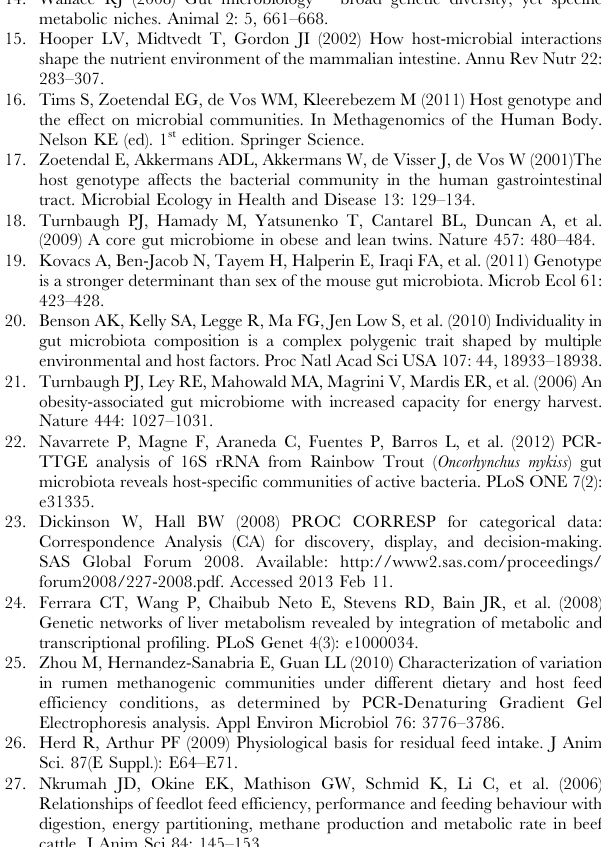
Table S1 Correlation (r) of fermentation metabolites in the rumen of ANG,CHA, and HYB steers under LE diet